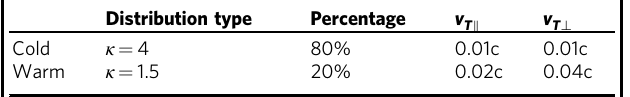
Table 2 The kappa distribution parameters in the model Distribution type